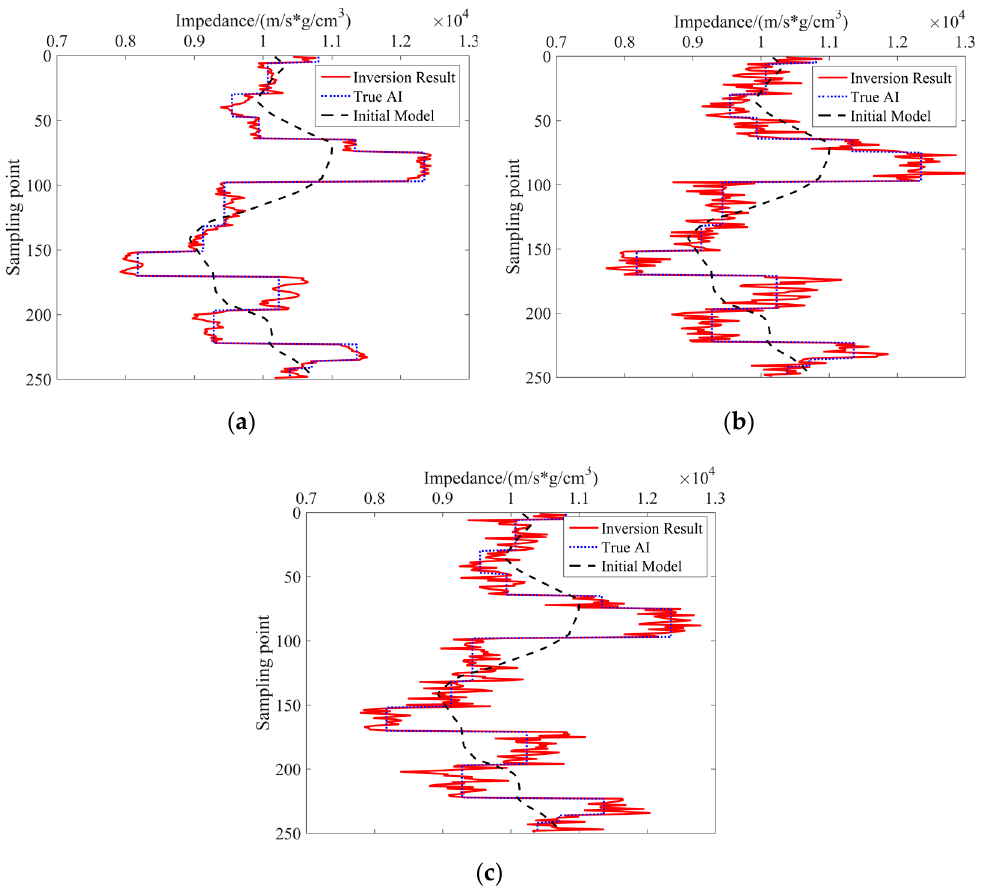
Figure 3. The inversion results of trace 301. ( a ) GMHDD; ( b ) Gaussian distributions of fixed parameters (GMH) and ( c ) Uniform distributions of fixed parameters (UMH).